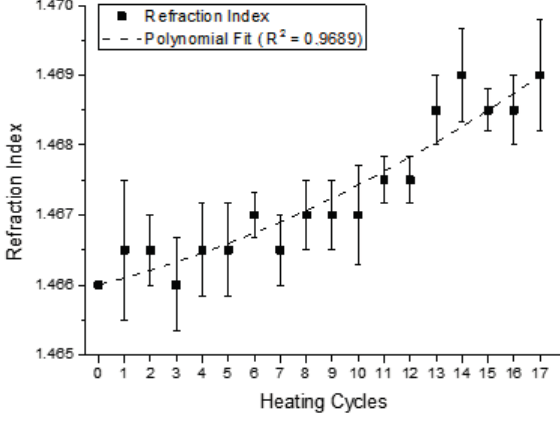
Figure 11. Value of the refraction index at 20 °C, for each one of the consecutive heating cycles.